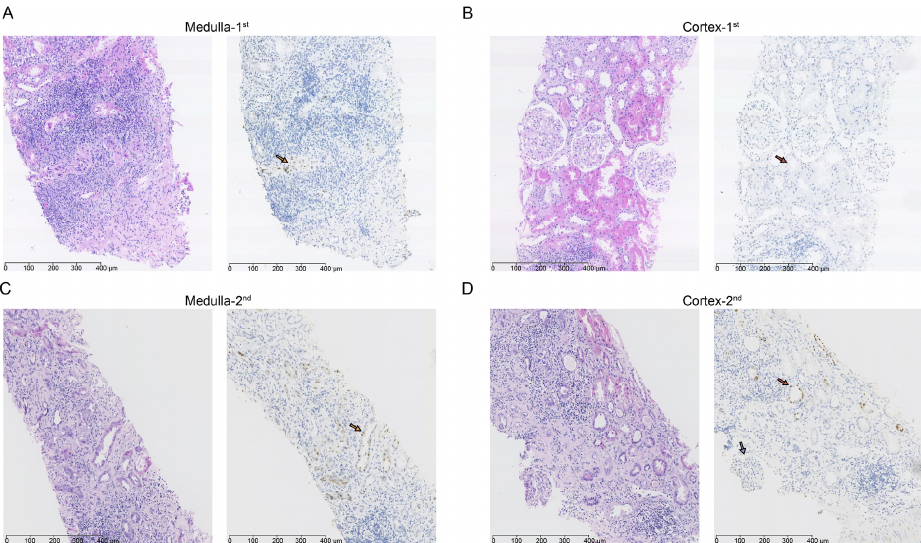
Figure 7. Evolution of BKPyV involvement to indirectly validate BKPyV tropism. The first biopsy ( A , B ) showed BKPyV only infected CD in the medulla (( A ) left side: H&E staining 200×; right side: IHC staining of SV40T of the same area) (yellow arrow), while PT in the cortex was uninfected (( B ) left side: H&E staining 200×; right side: IHC staining of SV40T of the same area) (red arrow). How- ever, a repeated biopsy (3 months later) revealed that BKPyV had evolved from the medulla (( C ) left side: H&E staining 200×; right side: IHC staining of SV40T of the same area) to PT in the cortex. The mesangial cells and endothelial cells within glomerular tufts were negative with anti-SV40T staining (purple arrow) (( D ) left side: H&E staining 200×; right side: IHC staining of SV40T of the same area). Arrows with different color represent different cells. PT: proximal tubule cells (red ar- row), CD: collecting duct cells (yellow arrow), GEC: glomerular endothelial cells (purple arrow).